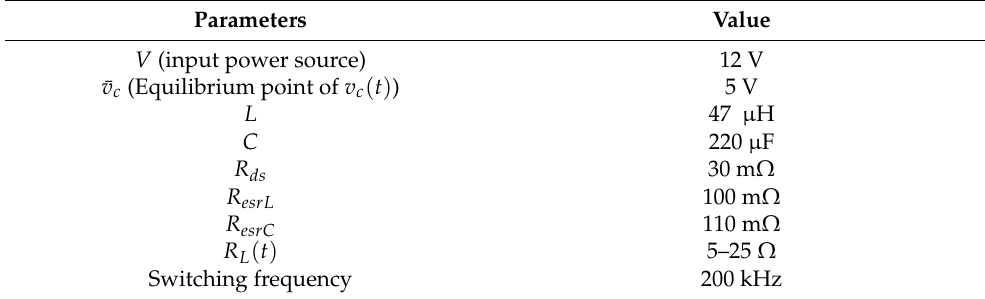
Table 1. Parameters of the DC–DC Buck converter.